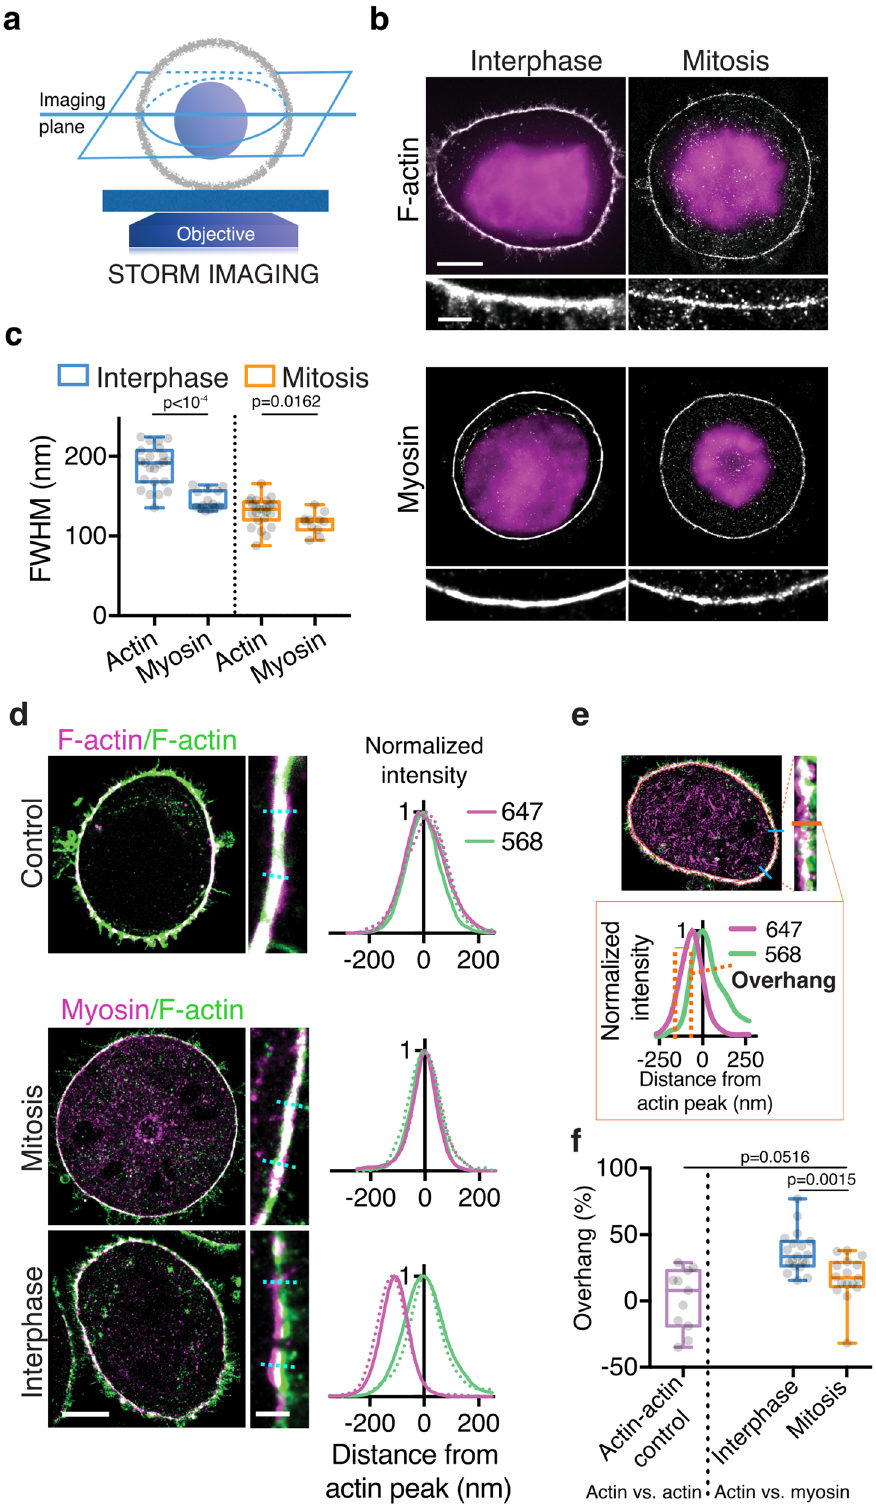
was observed in mitotic cells (Fig. 2f). Taken together, these results indicate that myosin-II motors do not completely penetrate the cortical actin layer in interphase